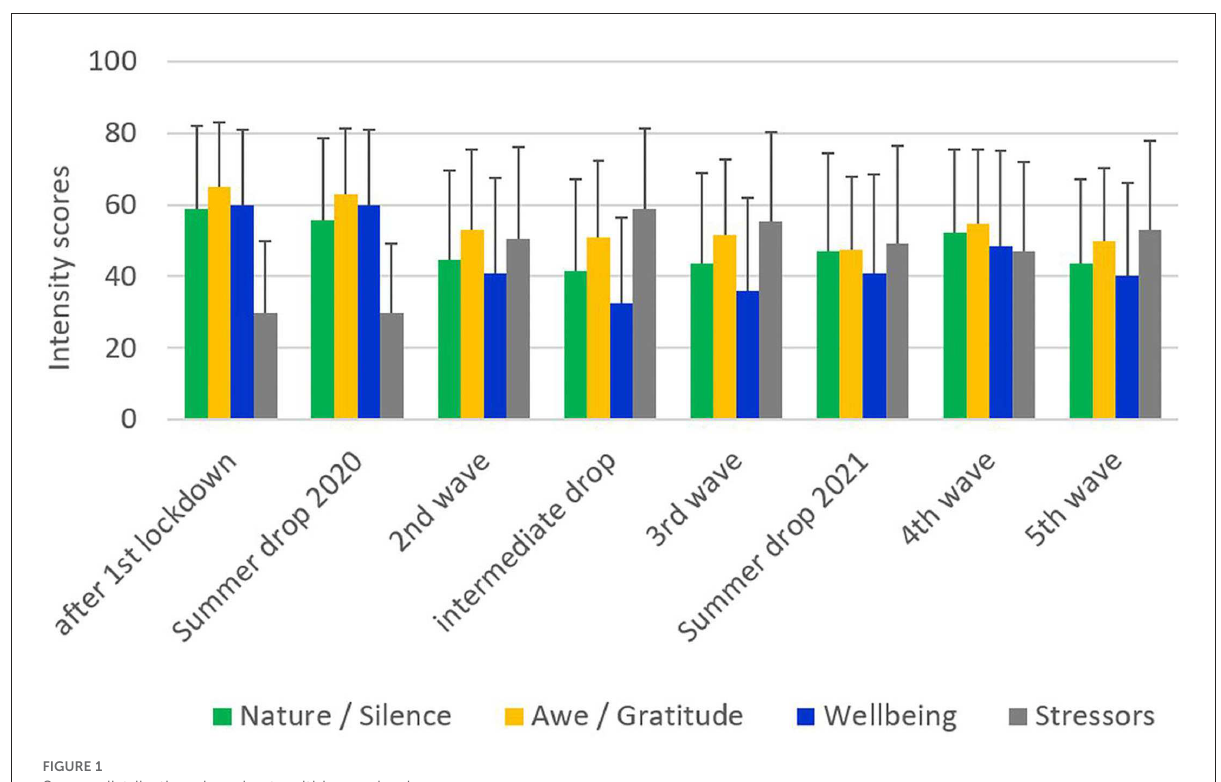
FIGURE1 Scores distributions in cohorts within